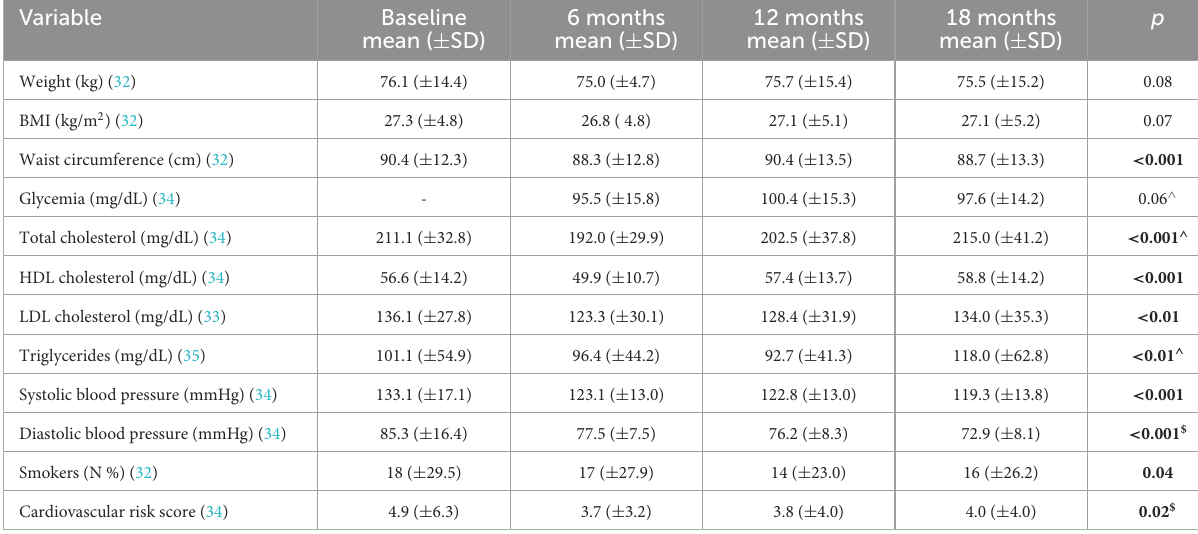
TABLE 2 Results of repeated measures